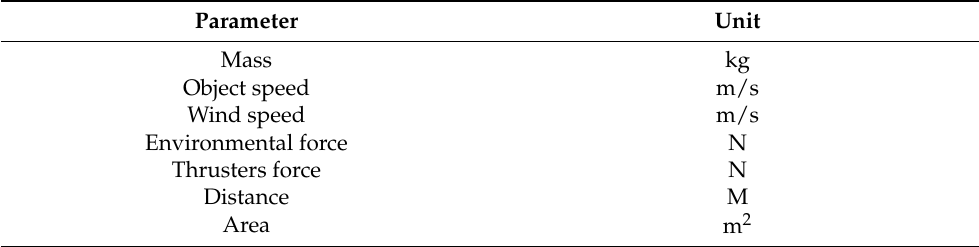
Table 1. Units used in